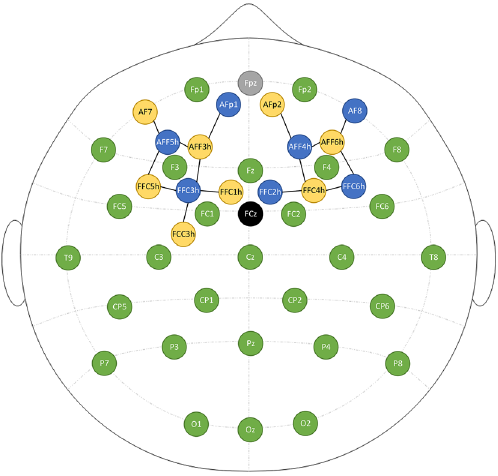
Figure 4. Combined fNIRS-EEG montage. Colours: Blue = fNIRS detector; yellow = fNIRS source incl. short distance channel; green = electrode, grey = ground electrode, black = reference